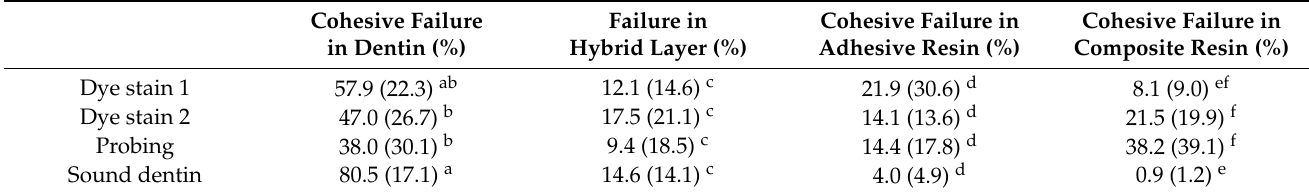
Values are means (standard deviations), n = 10 in each group. Groups identified by different letters